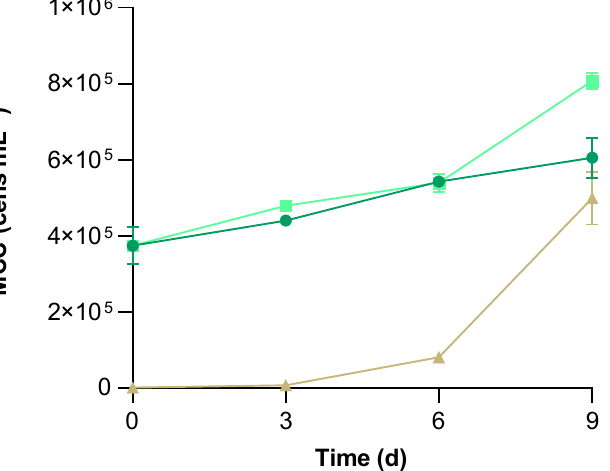
Figure 2. Microalgal cell concentration (MCC, average ± standard deviation) over time (d) for each PBR: (cid:4) CV ( C. vulgaris + UWW); (cid:4) C+ ( C. vulgaris + autoclaved UWW); and (cid:4) C − (raw UWW).